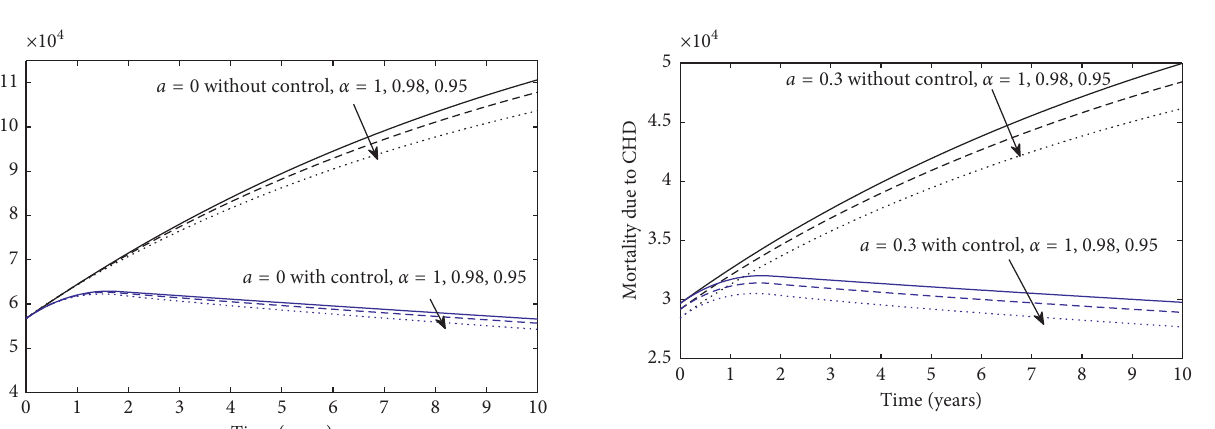
Figure 4: Mortality due to CHD, where a � 0 . 3 without control (black lines) and with control (blue lines) for α � 1 (solid line), α � 0 . 98 (dashed line), and α � 0 . 95 (dotted line).